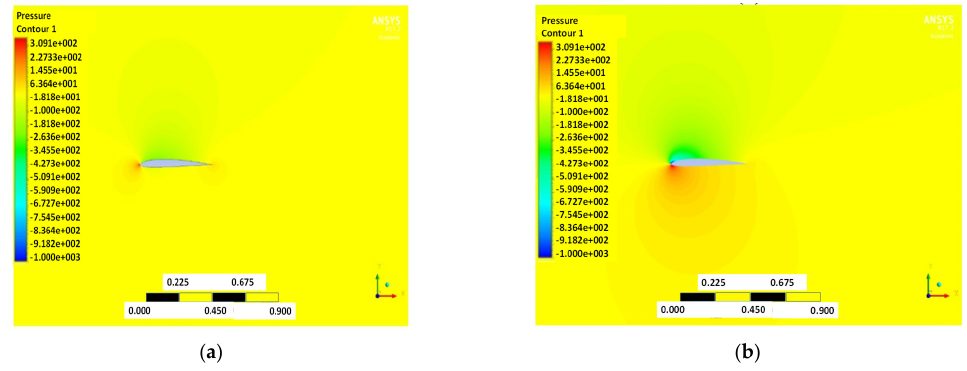
Figure 7. Pressure contour of NACA2410 with AoA ( a ) 1° and ( b ) 8°.